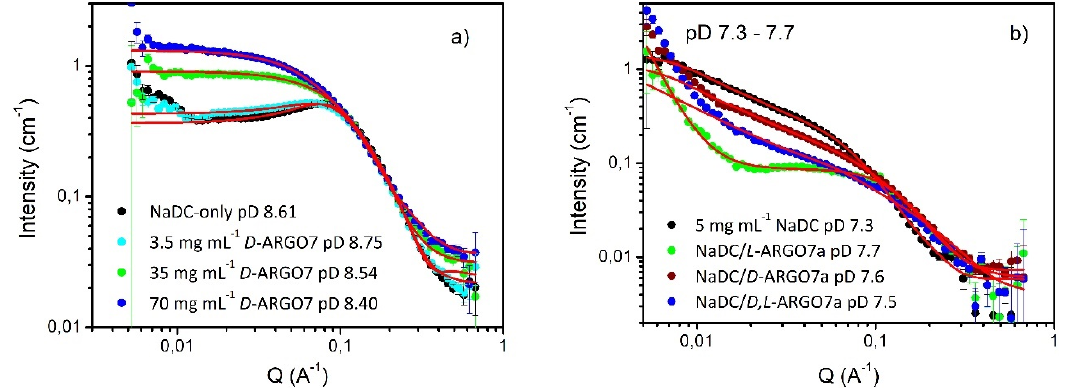
Figure 4. NaDC scattering data in presence of: panel ( a ) increasing concentration of D -ARGO7 and panel ( b ) D -, L -, D,L -ARGO7 with higher M n (named D -, L - and D,L -ARGO7a). Fittings are reported as red lines.